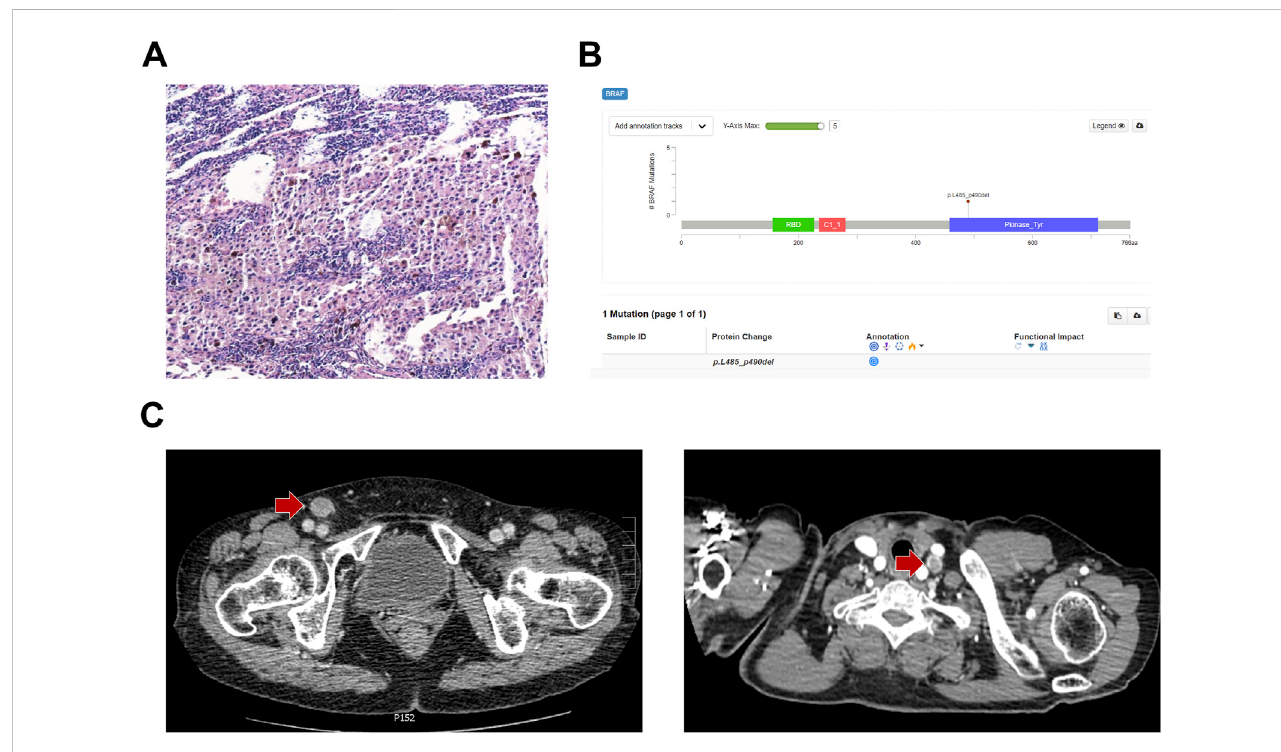
FIGURE 1 Melanomahistoryandgenestatusofthepatientatbaseline. (A) Immunohistochemistryand (B) next-generationsequencingresultsoftheinguinalregion mass biopsy. (C) Contrast-enhanced CT showed enhanced lymph nodes in the right inguinal region and the left cervical region at